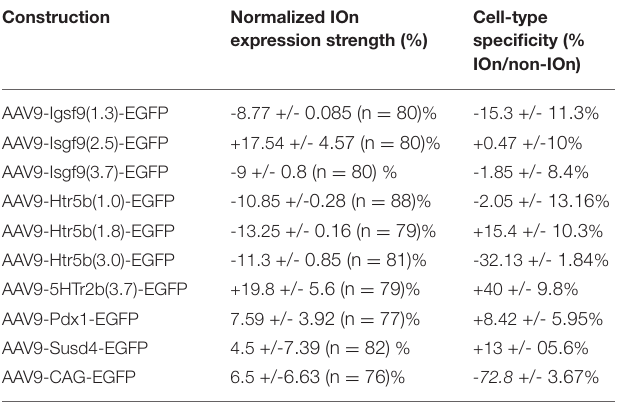
TABLE 2 | Anatomical characterization results for transgene expression in inferior-olive with custom AAV vectors.